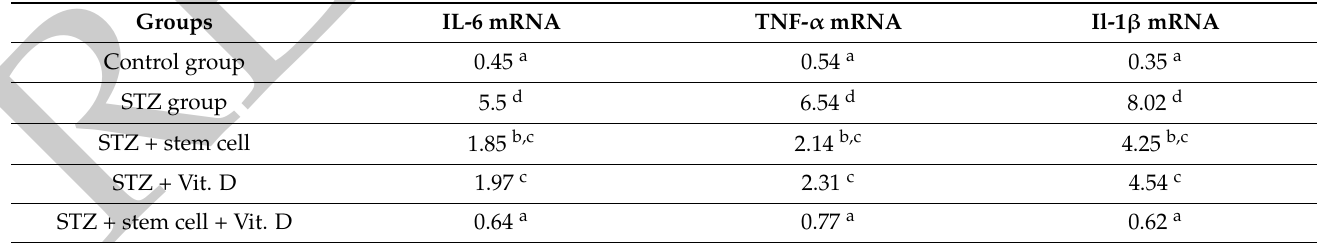
Table 6. Effects of either stem cell and/or vitamin D on inflammation were due to the gene regulation of inflammatory